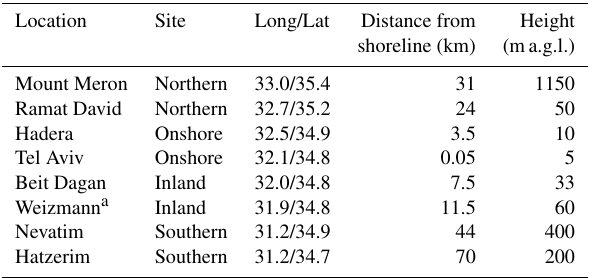
Table 2. Ceilometers’ locations. Table 3. Ceilometers’